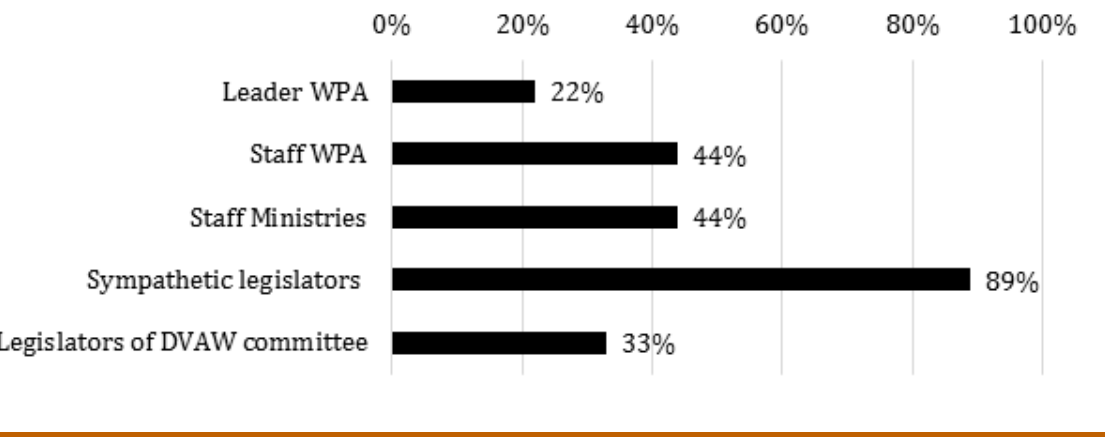
Source: Author’s own